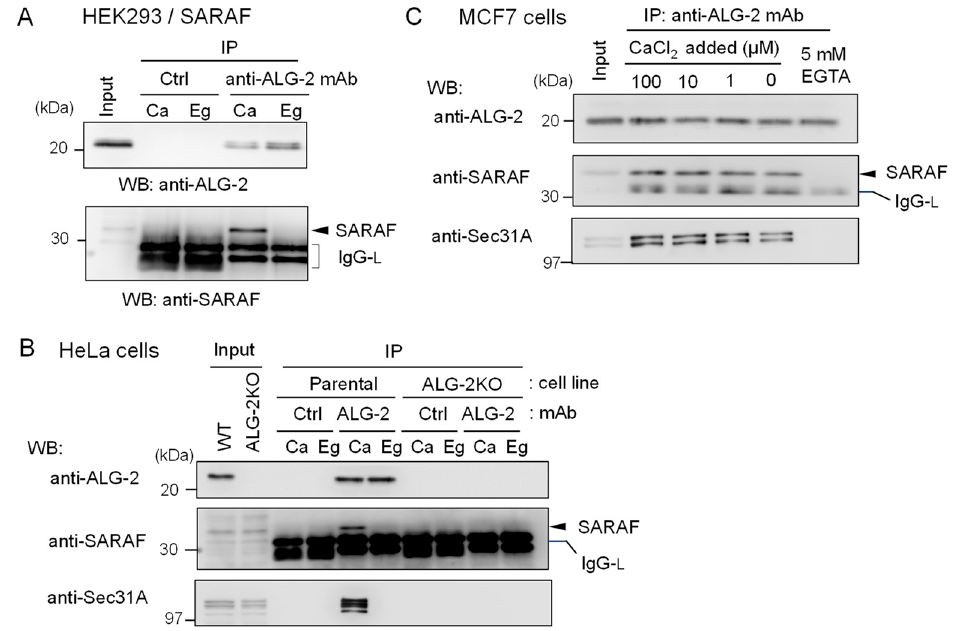
Figure 3. Reciprocal co-IP assay of ALG-2 and SARAF with anti-ALG-2 antibody. ( A ) HEK293 cells stably expressing untagged SARAF were used for co-IP assays in the presence of 100 µ M CaCl 2 ( Ca ) or 5 mM EGTA ( Eg ) with anti-ALG-2 mAb and control mouse IgG. Immunoprecipitates ( IP ) were analyzed by WB with anti-ALG-2 pAb and anti-SARAF pAb as indicated. IgG-L , IgG light chain. ( B ) Lysates of parental HeLa cells and ALG-2 knockout (KO) HeLa cells (ALG-2KO) were subjected to immunoprecipitation with anti-ALG-2 mouse mAb followed by WB with rabbit pAbs against ALG-2, SARAF and Sec31A as indicated. ( C ) A co-IP assay with anti-ALG-2 mAb was performed as shown in ( B ) but with the use of MCF7 cells in the presence of varying concentrations of exogenously added CaCl 2 or 5 mM EGTA as indicated.